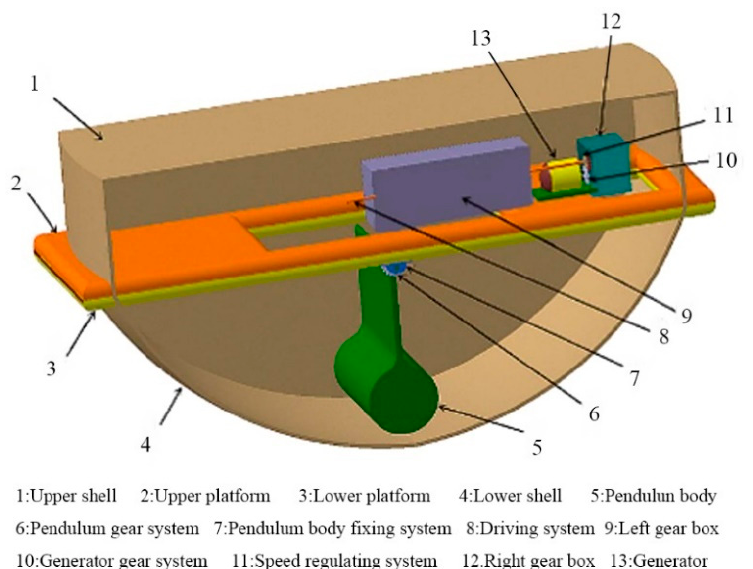
Figure 2. The pitch-float wave energy converter.